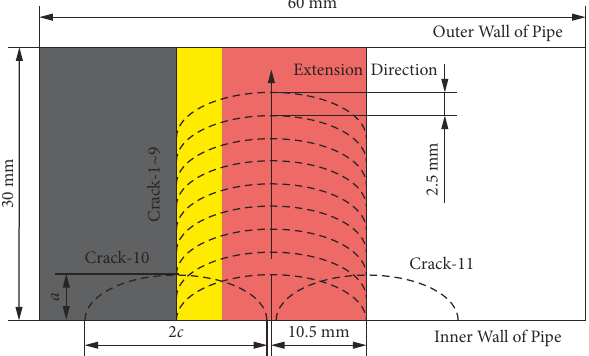
Figure 3: Sketch map of crack locations in the DMWJ sample.